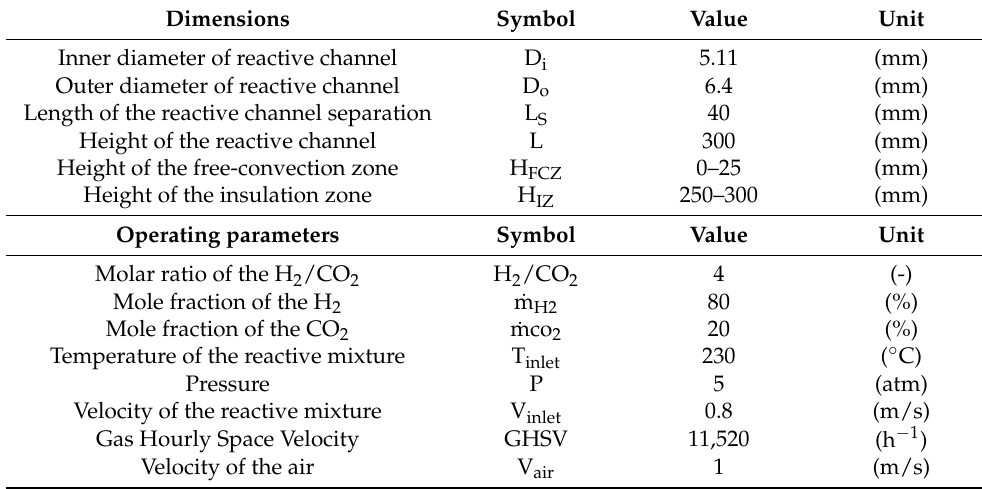
Table 6. Dimensions and operating parameters of the scaled-up multi-tubular fixed-bed reactor.